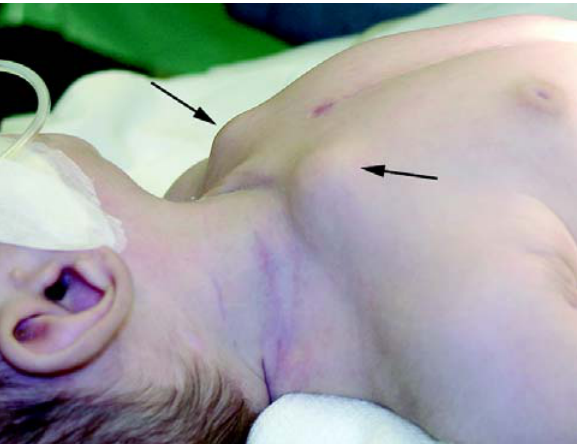
Fig. 4 - Botões auto-selantes posicionados na região infraclavicular, um para cada artéria pulmonar, para ajuste independente do fluxo sangüíneo pulmonar